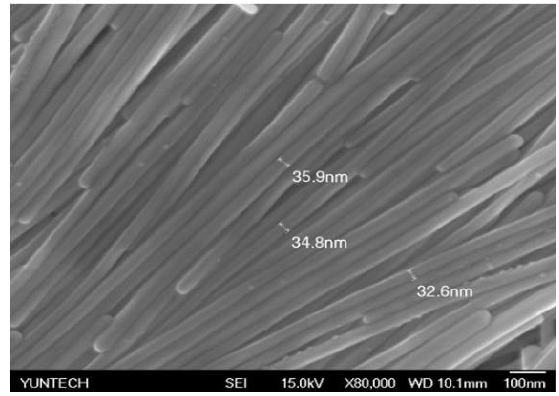
Energies 2021 , 14 , x FOR PEER REVIEW Figure 5. FE-SEM image of the AgNWs. Figure 5. FE-SEM image of the AgNWs.